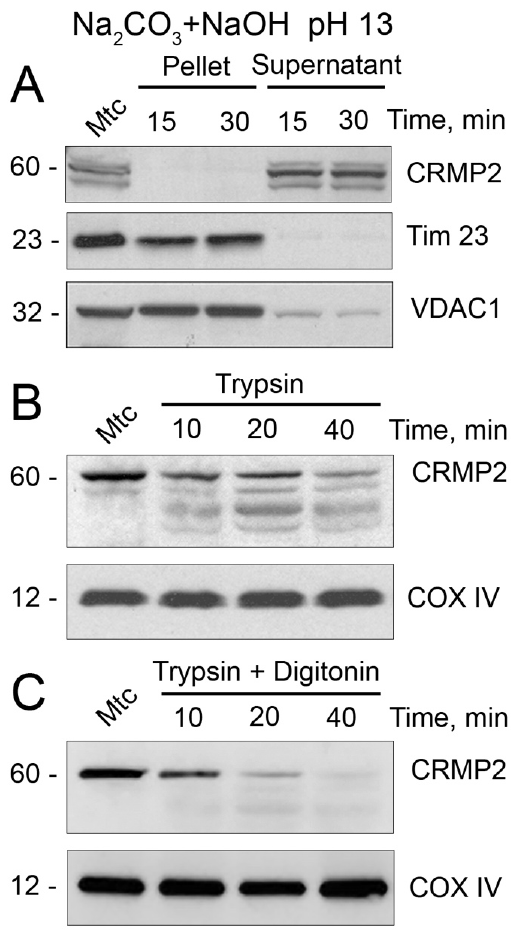
Figure 2. CRMP2 localization on mitochondria. ( A ) Alkali treatment removes CRMP2 from mitochondrial membranes, suggesting that CRMP2 is not embedded in the mitochondrial membranes. In ( A ), brain synaptic mitochondria were in- cubated on ice at 0 °C for the indicated time with 0.1 M Na 2 CO 3 , pH was adjusted to 13 with NaOH. Then, mitochondrial membranes were pelleted and CRMP2 presence in the pellets and supernatants was evaluated using immunoblotting. Tim 23 is a marker for the mitochondrial inner membrane; VDAC1 is a marker for the mitochondrial outer membrane. ( B,C ) Trypsin treatment degrades CRMP2 bound to purified synaptic brain mitochondria from FVB/NJ mice ( B ). In ( B ), mito- chondria were incubated on ice at 0 ° C for the indicated time with 40 μ g/mL trypsin. In ( C ), mitochondria were incubated on ice at 0 ° C for the indicated time with 40 μ g/mL trypsin plus 10 μ g/mL digitonin. Without trypsin, CRMP2 was not degraded. Cytochrome oxidase subunit IV (COX IV) is a loading control. Mtc, mitochondria. Representative Western blots from 3 independent experiments are